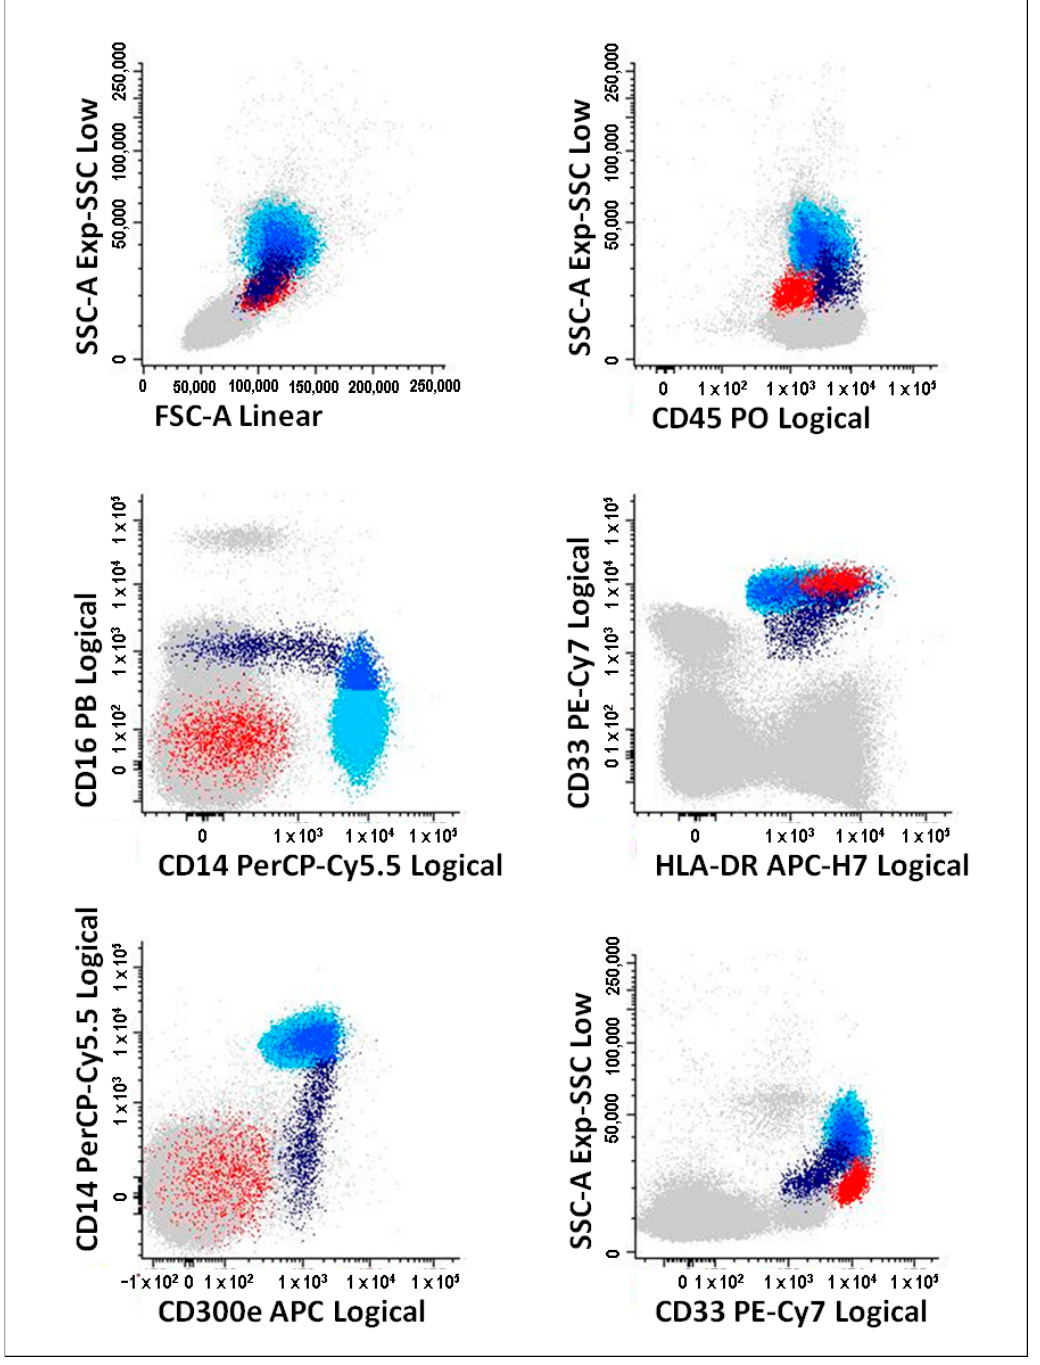
Figure 1. Gating strategy to identify peripheral blood monocyte subsets (classical, intermediate and non-classical) and mDCs. Classical monocytes (light blue events) were identified as CD14 + CD16 − , with high levels of CD33, CD300e (or IREM-2), CD45 and HLA-DR; the blue events correspond to intermediate monocytes which are CD14 + CD16 − /+ , with high reactivity for CD300e; non-classical monocytes (dark blue events) were identified as CD14 +/ − CD16 + , with high levels of CD45 and CD300e, and low CD33 levels; mDCs (red events) are phenotypically characterized as CD14 - CD16 - CD300e - , with low levels of CD45 and low SSC light dispersion properties, presenting higher levels of CD33 and HLA-DR than monocytes. Grey events correspond to the remaining PBMC populations: lymphocytes, plasmacytoid dendritic cells and basophils. mDCs, myeloid dendritic cells; PBMCs, peripheral blood mononuclear cells.